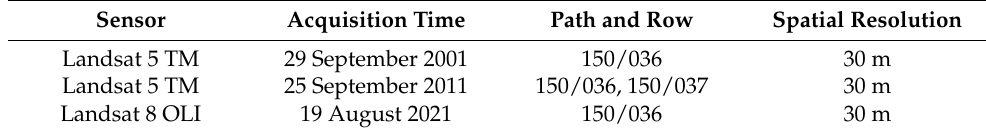
Table 1. Characteristics of Satellite images. Sensor Acquisition Time Path and Row Spatial